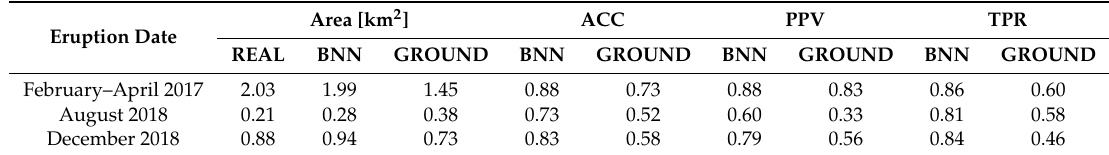
Table 1. Comparison between lava flows extracted from Sentinel-2 MSI data (BNN), ground-based measurements (GROUND), and PlanetScope images (REAL). For each event, the areal extents and the results for the three performance indices ACC, PPV and TPR are reported. Ground-based areas were extracted from the weekly INGV bulletins (available